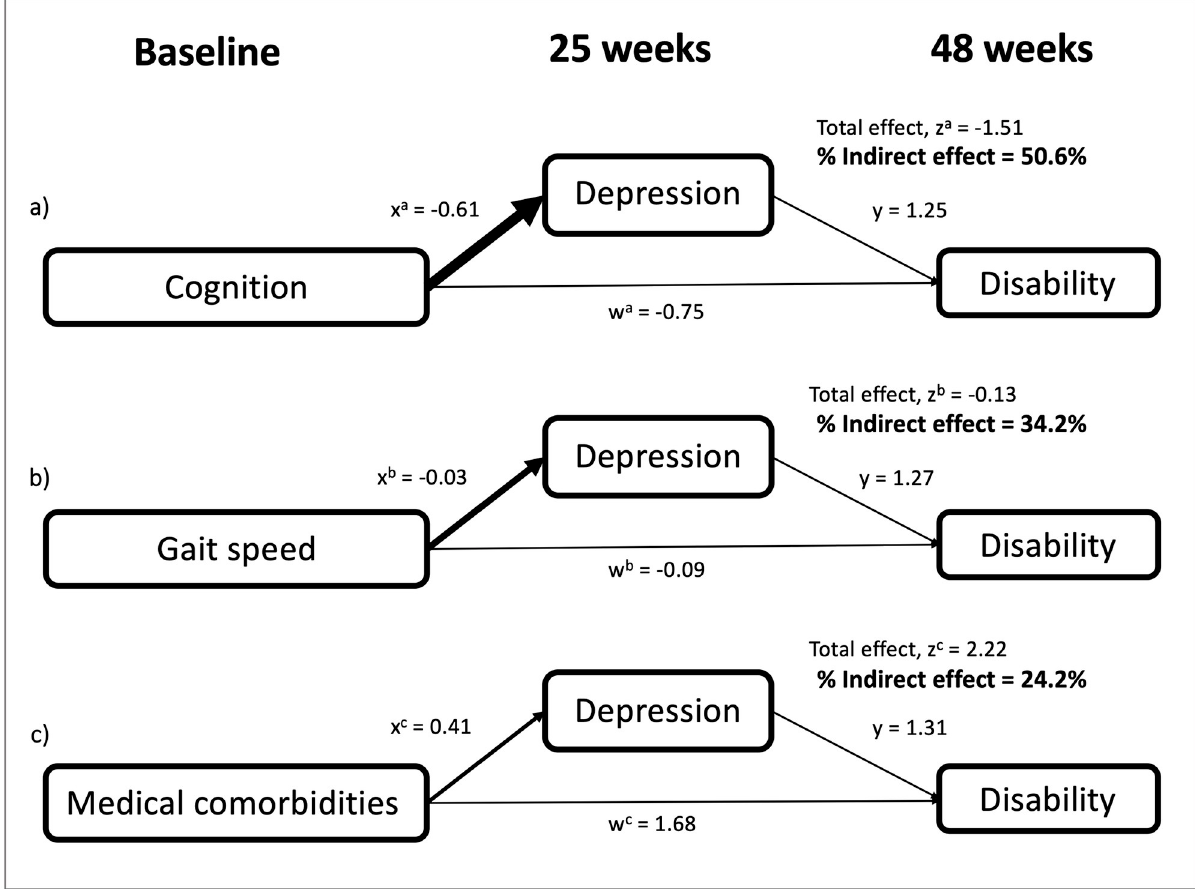
Fig 4. Longitudinal mediation analysis models. A mediation analysis was performed to measure the extent to which depressive symptoms on the Geriatric depression scale (GDS) exacerbate the effects of (a) cognition, (b) gait speed, and (c) medical comorbidities on disability over 48 weeks. To investigate possible causality, the models used values from each independent variable at baseline, depressive symptoms at 25 weeks, and disability at 48 weeks. Coefficients for Direct pathways (w) and Indirect pathways (x and y) are shown. The “w” pathway represents the direct effect of each independent variable on disability, independent from the effect attributable to mediation by GDS. The “x” pathway represents the effect of each independent variable on GDS. The “y” pathway represents the effect of GDS on disability. The “z” coefficient represents the total effect, including both the Direct and Indirect pathways. The percent Indirect effect was calculated as % Indirect effect = (x � y)/z. Depressive symptoms accounted for 24–51% of the effect of each independent variable on disability in these longitudinal